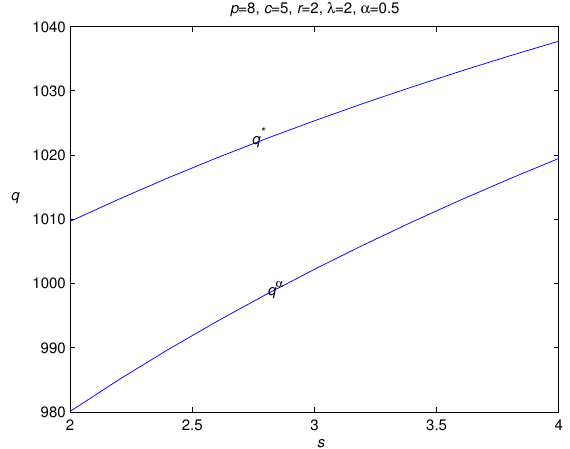
Figure 4. Optimal order quantities q ∗ and q α with different shortage penalty prices s .